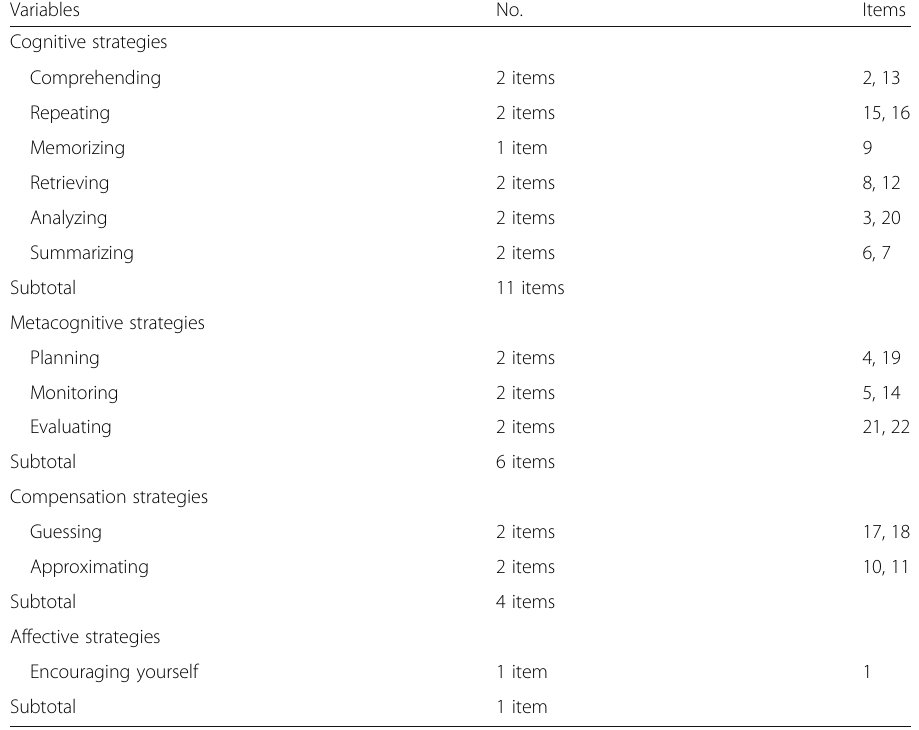
Table 3 Composite for paraphrasing strategy use inventory